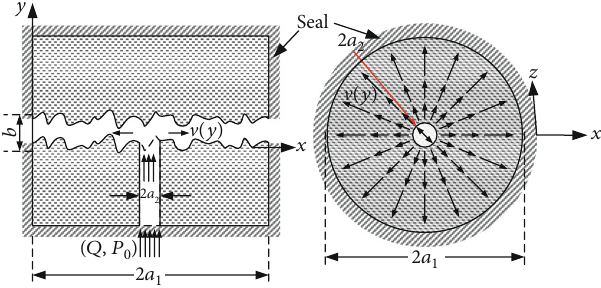
Figure 7: Radial direction of the mixture in